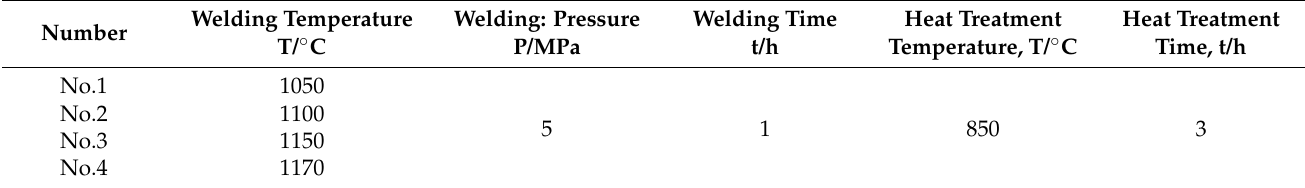
Table 2. The diffusion bonding parameters of FHG98 and